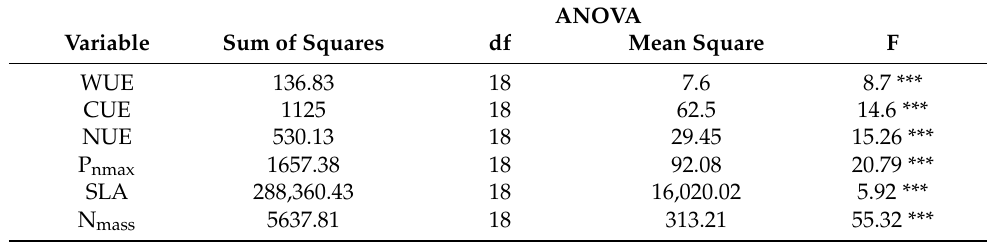
Table 3. Analysis of variance of leaf functional traits and resource utilization efficiencies of different species. ANOVA Variable Sum of Squares df Mean Square F WUE 136.83 18 CUE 1125 18 62.5 530.13 288360.43 5637.81 Note: *** indicate p < 0.001. tree shrub tree shrub 162432 F=20.37 p<0.001 F=13.53 p<0.001